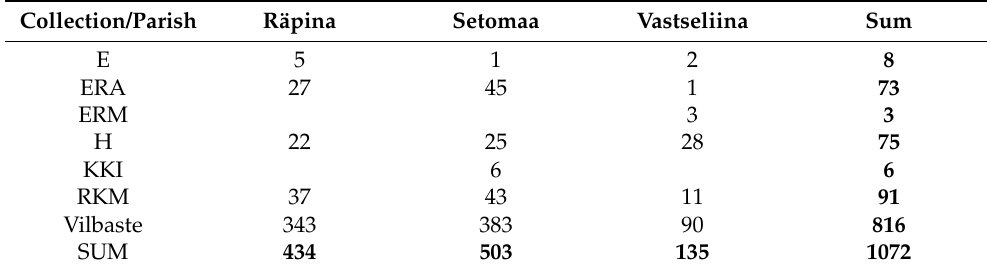
Table 2. The use records (UR) remaining for analysis after the cleaning of the data and identification of the plants.